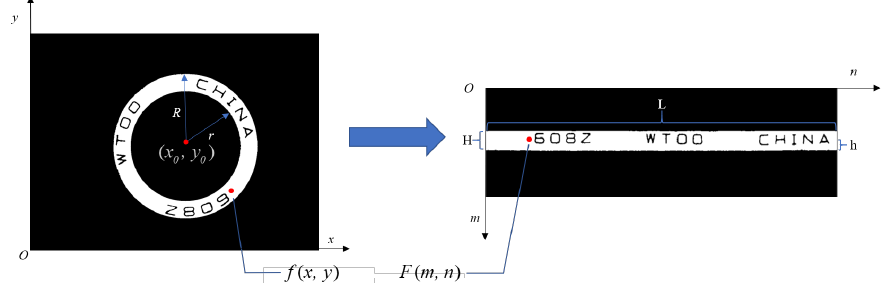
Figure 7. Polar to Cartesian coordinate